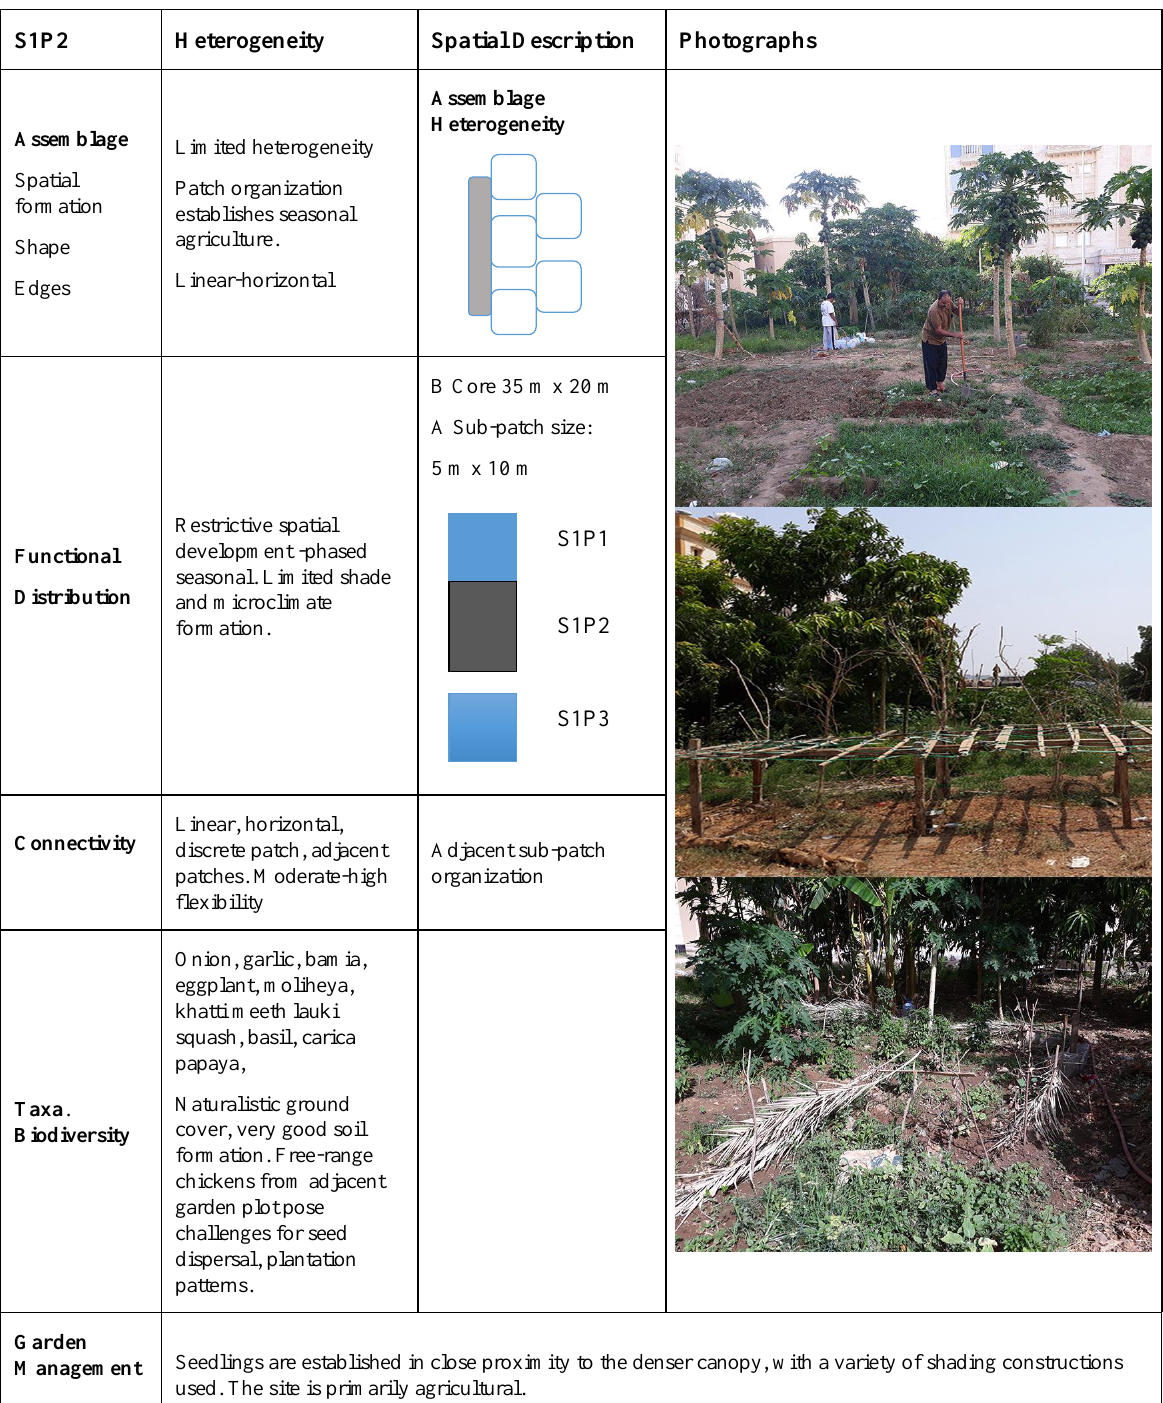
Table 3. Site1 Patch1 description of constructed